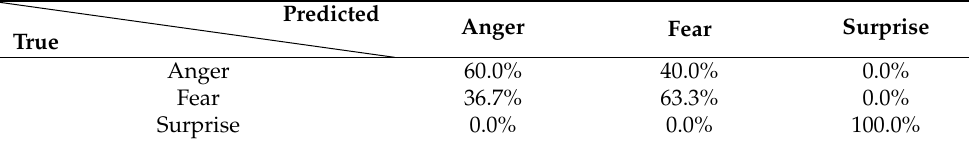
Table 5. Confusion Matrix on the logistic regression classifier for fear, anger, and surprise.